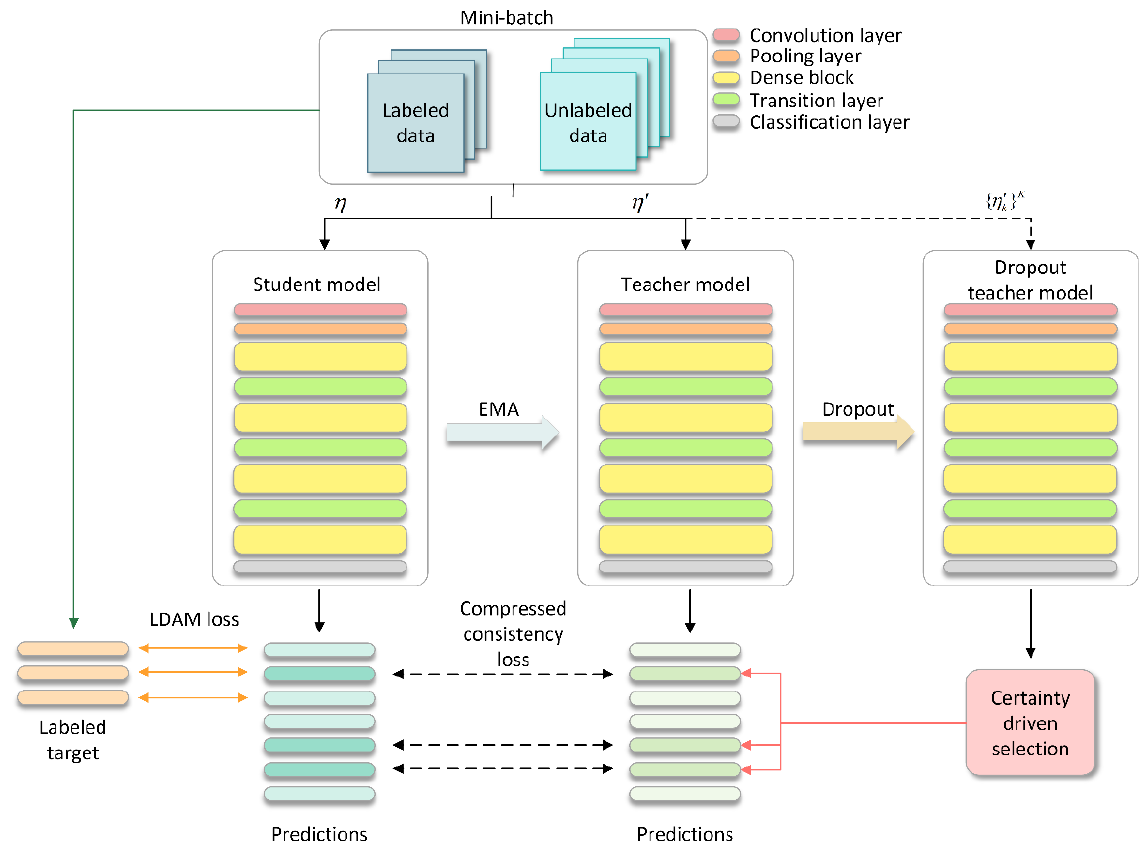
Figure 2. Class-imbalanced semi-supervised learning framework.